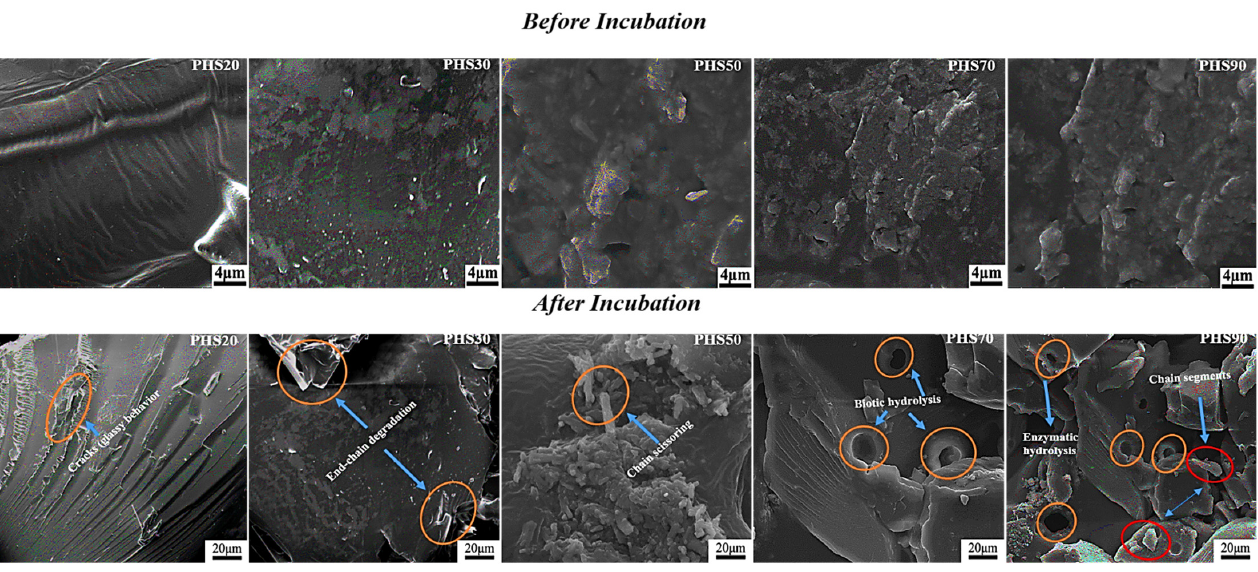
Figure 10. SEM images for PHS(20–90) films before and after 28 weeks of incubation in the enzymatic solution at neutral pH.